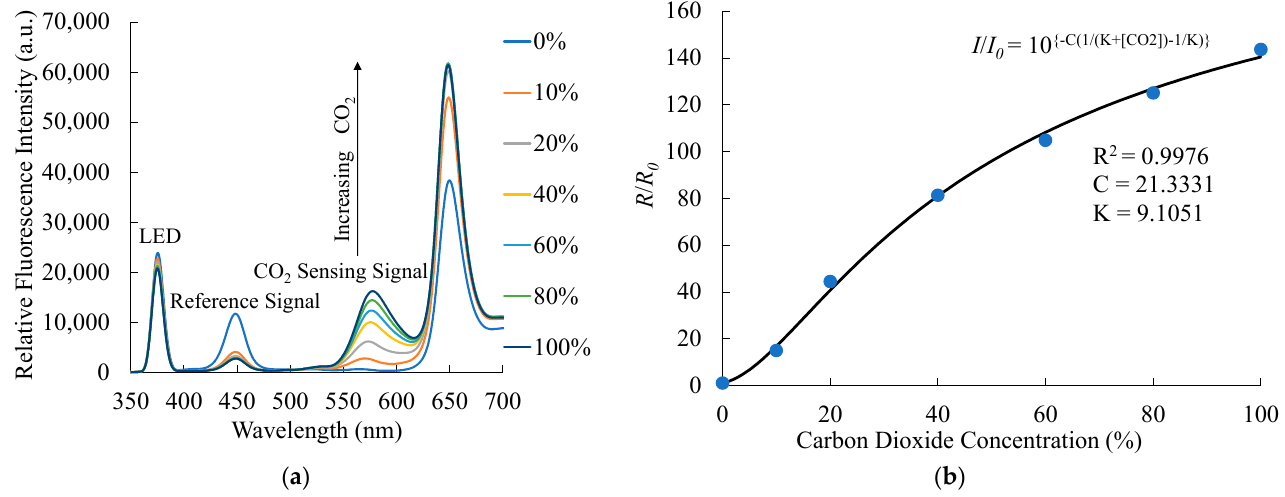
Figure 5. ( a ) Response of the optical dual sensor under exposure to seven CO 2 concentrations and ( b ) Variation of R / R 0 with 0-100% CO 2 concentrations.